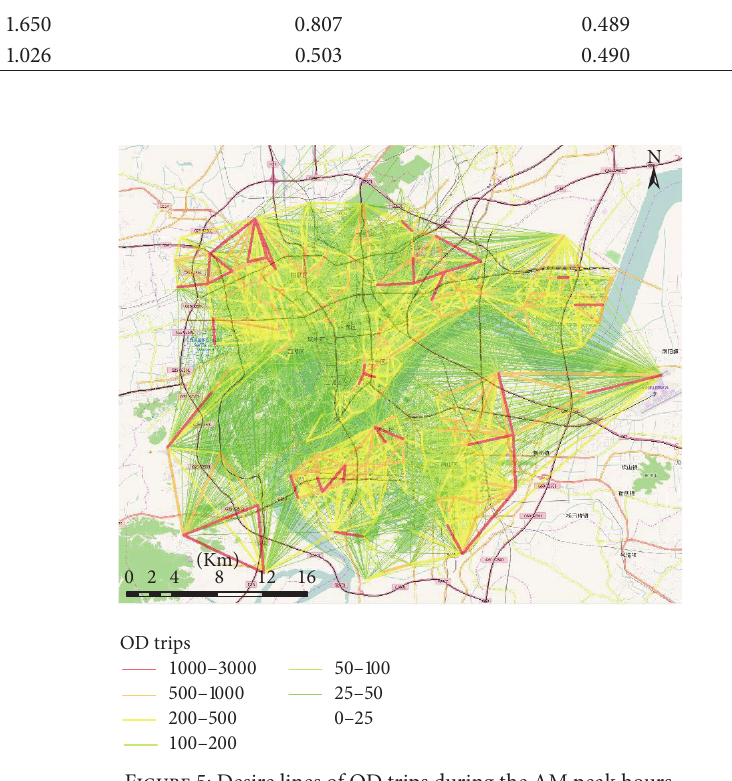
Figure 5: Desire lines of OD trips during the AM peak